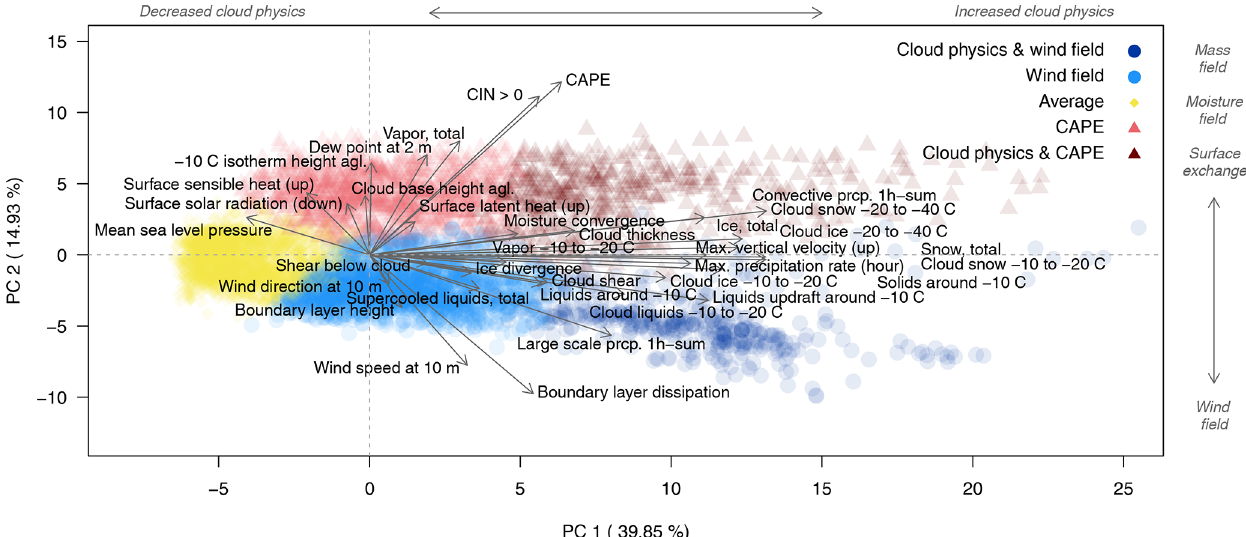
Figure 2. Plot of the 6304 cell-hours separated into five clusters by k -means clustering (colored symbols) and then projected onto their first two principal components (PC 1 and PC 2). Labeled arrows (biplot) show the loading of each variable (35 in total), i.e., how it contributes to creating the first two principal components. The top and right axes are labeled (in italics) to indicate the dominant physical categories defined in Sect. 3.2. Note that the orientation of the arrows in the surface-exchange category depends largely on how the flux direction is defined.